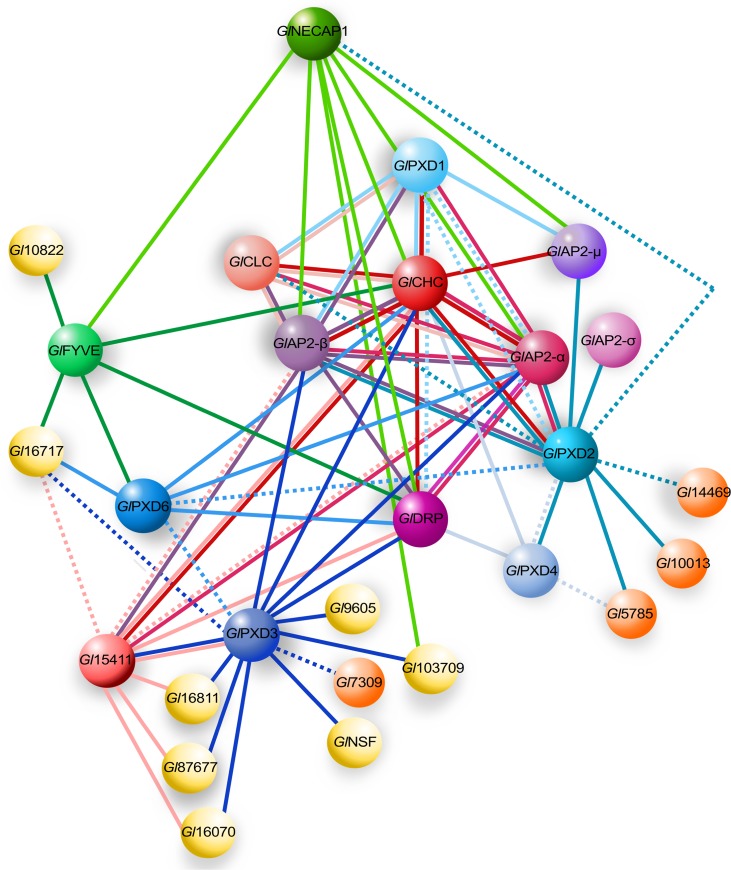
Overview of core protein interactomes determined from co-IP analyses.Interactomes for GlFYVE, GlNECAP1 and GlPXD3, 4, and 6 defined by co-IP analysis were integrated with previously published data [19] for core clathrin assembly, GlPXD1, GlPXD2 and GlFYVE interactomes. Solid lines: interactions detected at high stringency. Dashed lines: interactions detected at low stringency. Yellow partners are currently annotated on GDB as “hypothetical protein” i.e. proteins of unknown function.